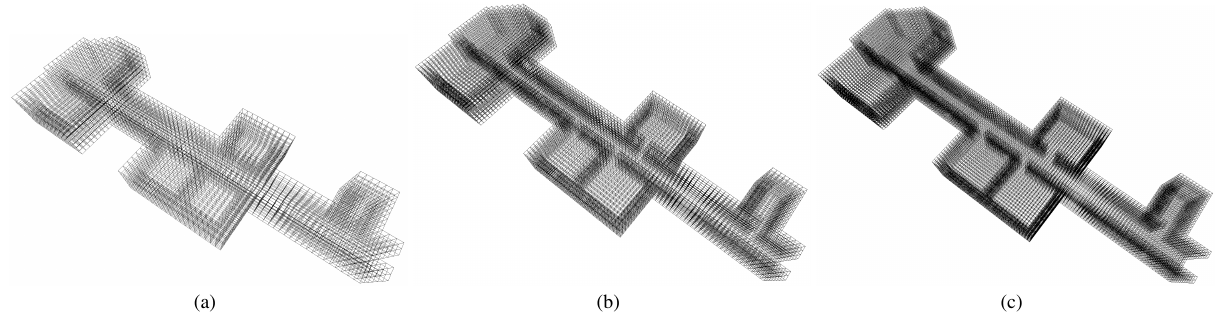
Figure 3. Example of progressively increasing voxelized mesh, based on the corresponding BIM geometry mesh. (a) 3608 voxels (approximate resolution of 64 3 ), (b) 8345 voxels (approximate resolution of 96 3 ), (c) 14604 voxels (approximate resolution of 128 3